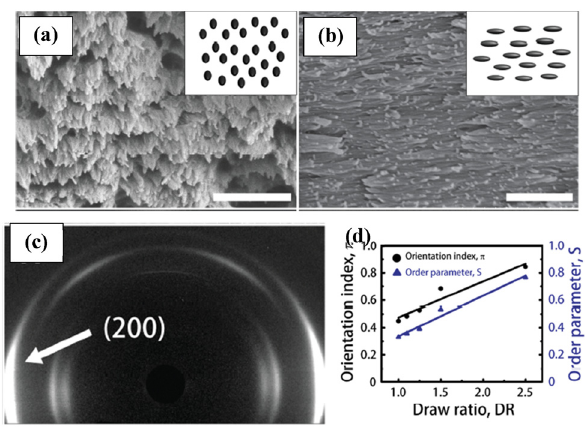
Figure 13: SEM images of a fractured cross section of a drawn and strongly aligned fi lm, DR = 2.5, acquired ( a ) perpendicular to and ( b ) within the drawing direction ( scale bars are 500 nm ) , 2D WAXD data to characterize the extent of alignment, ( c ) DR = 2.5. ( d ) Orientation index, π , and order parameter, S , as a function of DR, establishing a direct link between drawing and orientation of the reinforcements. Adapted from ref. [ 72 ]